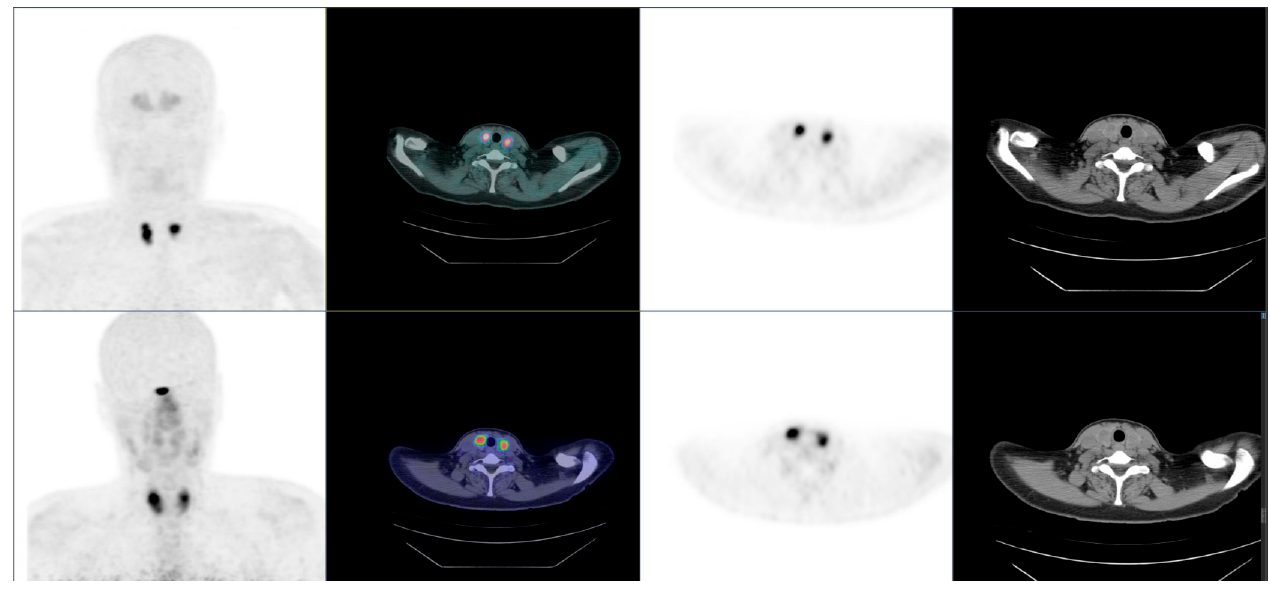
Figure 7. Bifocal and bilateral medullary thyroid carcinoma. Pre ‐ operative PET/CT: primary tumors positive at [ 18 F]FDOPA ( top ) and [ 18 F]F ‐ SiFAlinTATE ( bottom ).